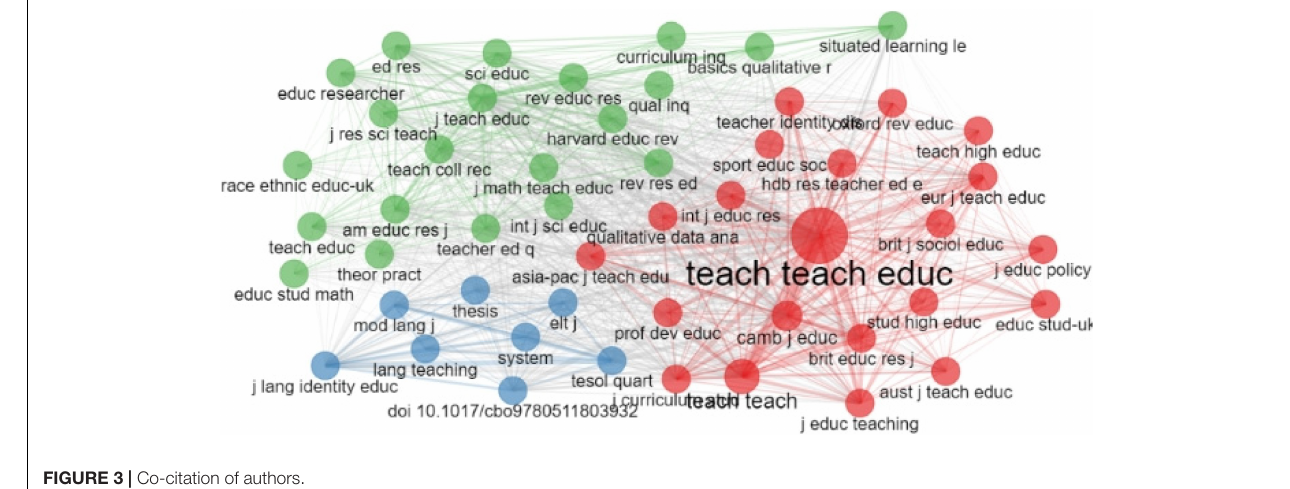
FIGURE 3 | Co-citation of authors.